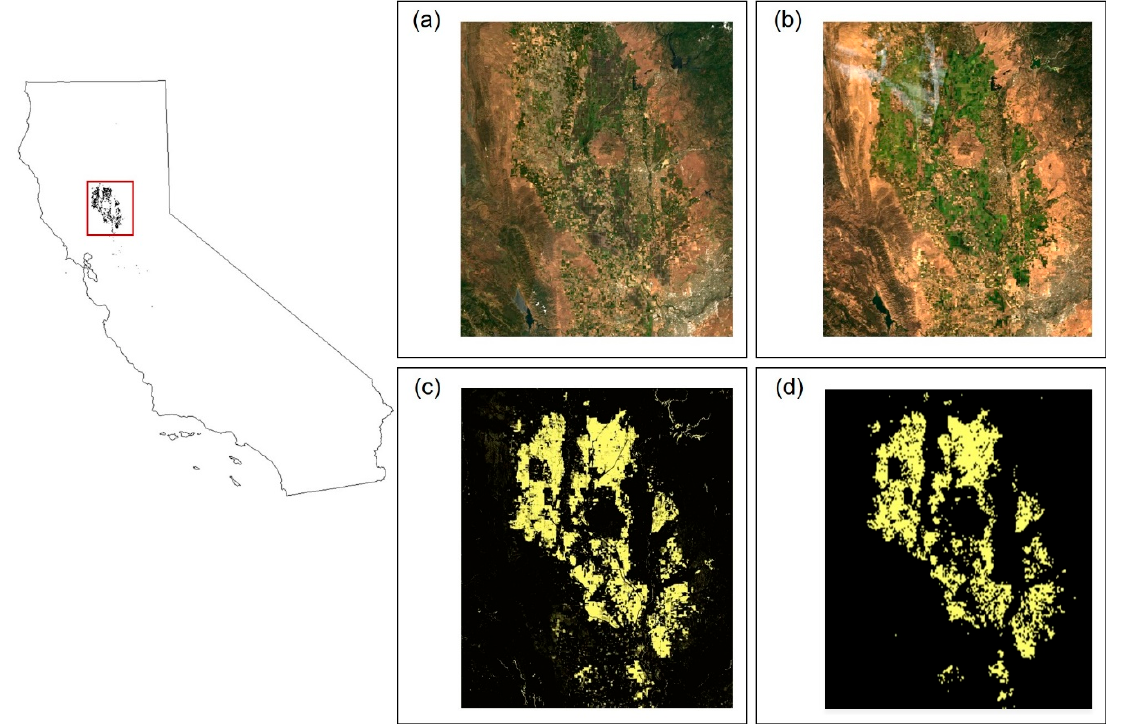
Figure 9. Spatial distribution of paddy rice maps at California State based on Google Earth Engine. ( a ) RGB image from Landsat 8 on 26 May 2016 (planting season); ( b ) RGB image from Landsat 8 on 30 August 2016; ( c ) PMI result; and, ( d ) reference map. Paddy rice fields are shown in yellow.